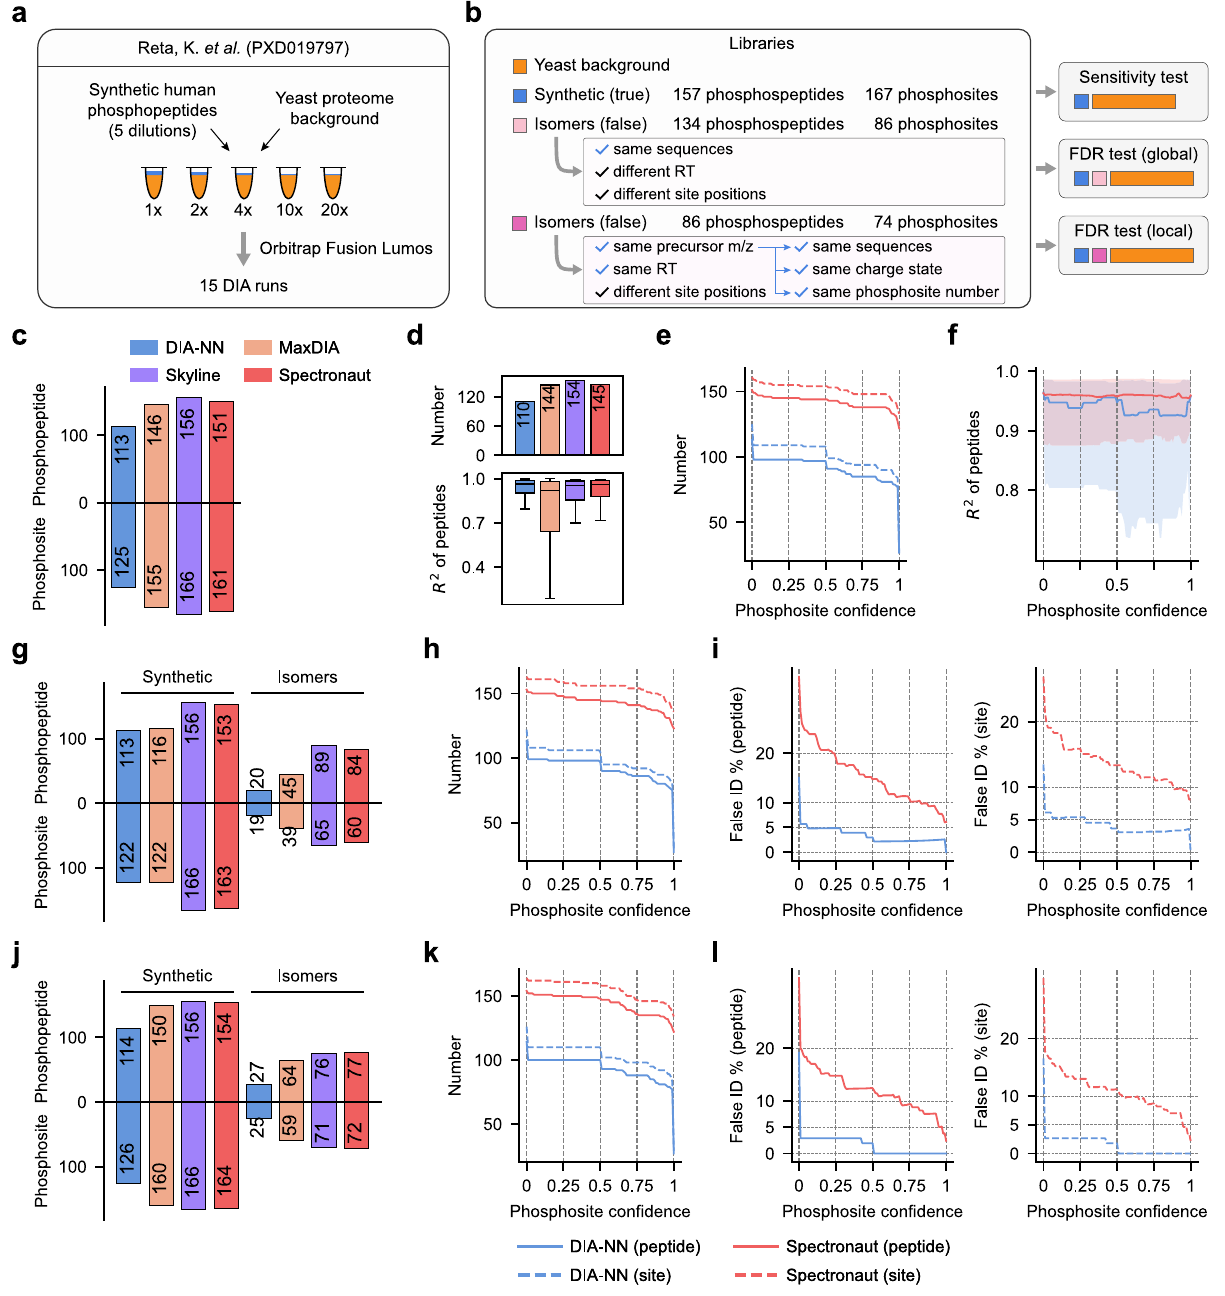
Fig. 4 | Evaluation of phosphopeptide identi fi cation and phosphosite locali- zation. a A phosphopeptide benchmark data set was obtained from synthetic humanphosphopeptides spiked intoayeastproteome background at fi ve dilution concentrations. b Design of spectral libraries for three tests. See textand methods for details. c Number of identi fi ed synthetic phosphopeptides and phosphosites (true hits) in the sensitivity test. d Quanti fi cation linearity of identi fi ed synthetic phosphopeptides across the dilution series. The valid numbers of quanti fi ed pro- teins are shown in the upper panel. e Number of phosphopeptides and phospho- sites as a function of the phosphosite con fi dence score cutoff. For peptides with multi-phosphosites,allsitesneedtopassthescorecutoff. f Quanti fi cationlinearity